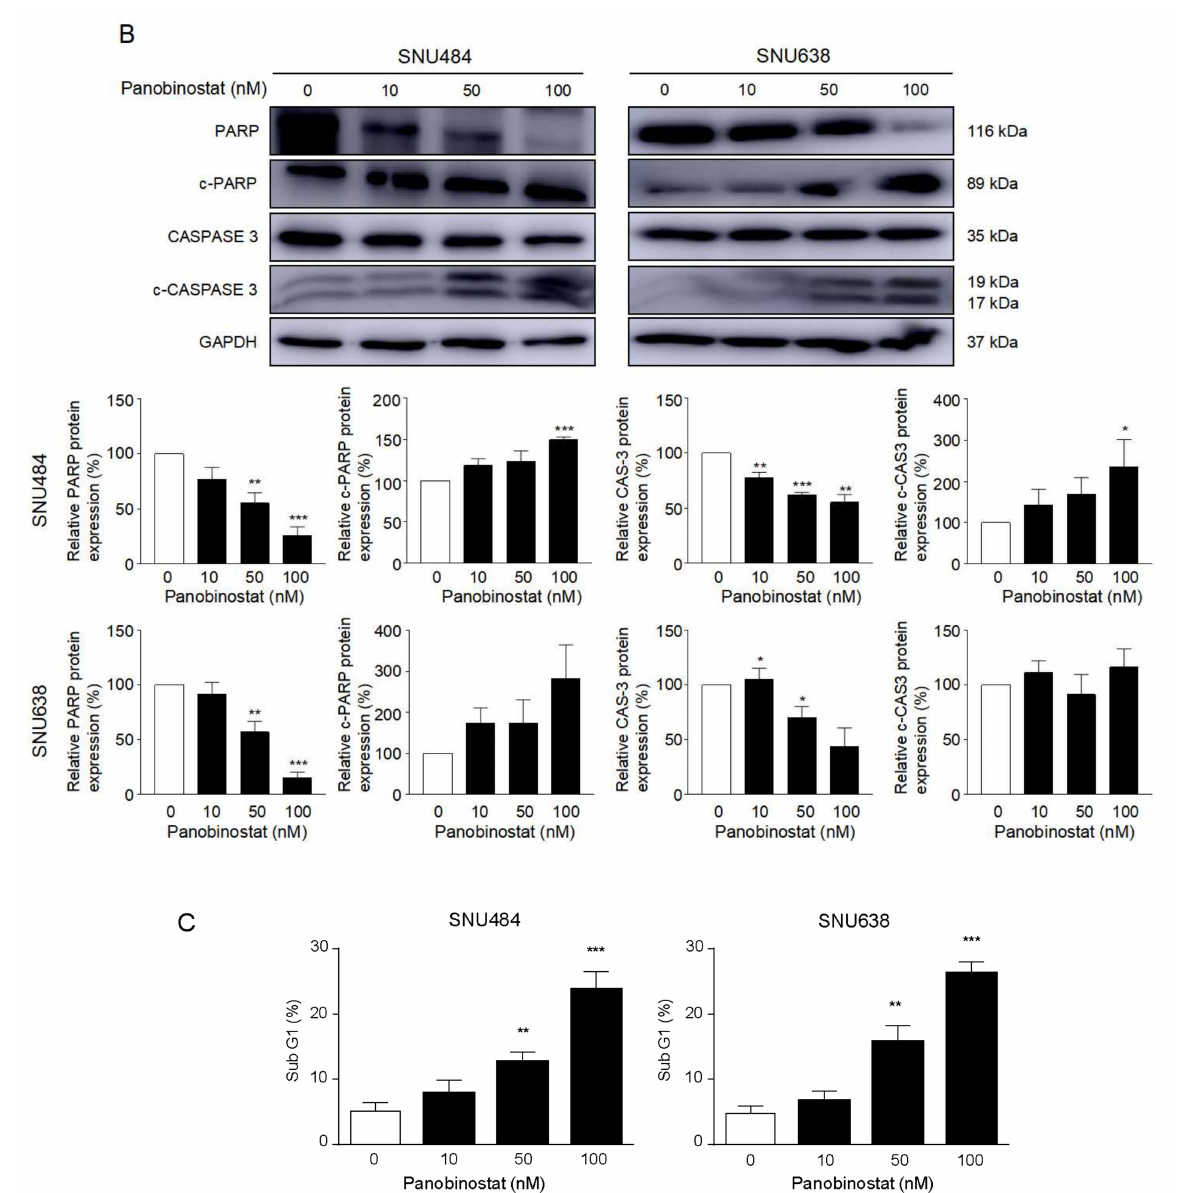
Figure 2. Panobinostat induces apoptosis in gastric cancer cells. SNU484 and SNU638 cells were treated with panobinostat (0, 10, 50, and 100 nM) for 48 h. ( A ) The induction of apoptosis was determined by annexin V–FITC/PI staining and flow cytometry analysis. The apoptotic regions were quantitatively analyzed. Data are shown as the mean ± SE of more than three independent experiments. * p < 0.05, compared with the control. PI, propidium iodide. Gray color; late apoptotic cells, black color; early apoptotic cells. ( B ) Western blot analysis of PARP, cleaved PARP, caspase-3, and cleaved caspase-3 in SNU484 and SNU638 cells harvested at 48 h after panobinostat treatment (0, 10, 50, and 100 nM). GAPDH was used as an internal control. The Western blot band intensity was quantitatively analyzed using ImageJ software (NIH, Bethesda, MD, USA). ( C ) Cell cycle distribution was detected by PI staining and flow cytometry. The proportion of cells in the sub-G1 phase was dose-dependently increased. Data represent the mean ± SE of three independent experiments. ** p < 0.01 and *** p < 0.001 compared with the control. FITC, fluorescein isothiocyanate; PARP, poly ADP-ribose polymerase; PI, propidium